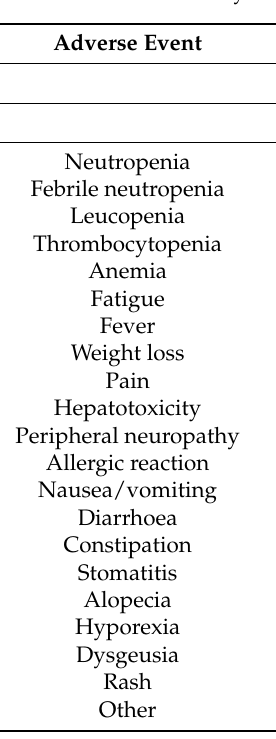
Table 2. Maximum toxicity in 73 patients treated with GEMOX + tomotherapy.